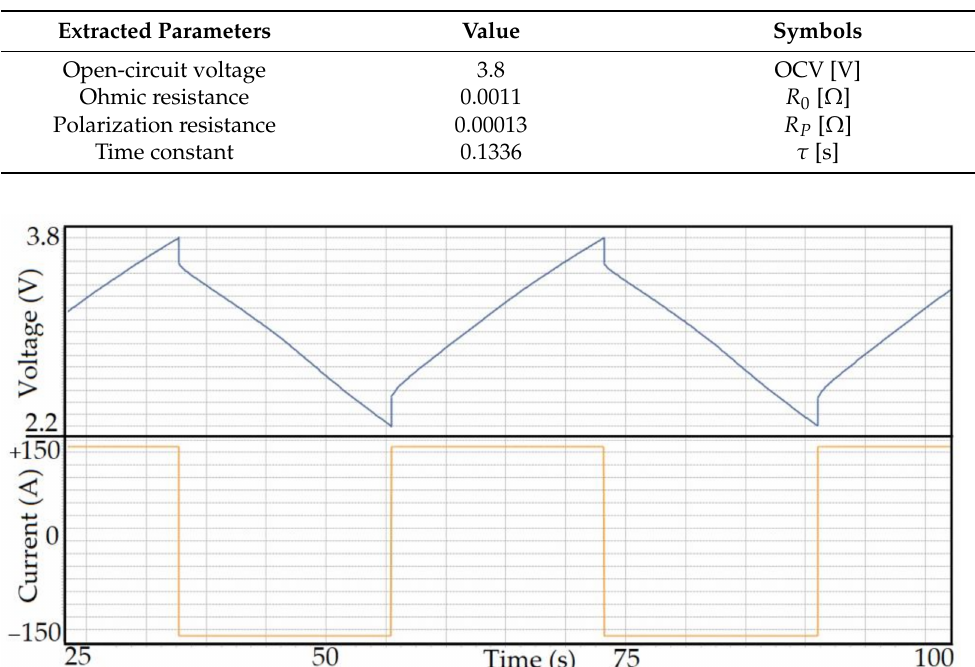
Table 2. Extracted parameters of the electrical model at 25 ◦ C, 150 A current rate, and 100% SoC.